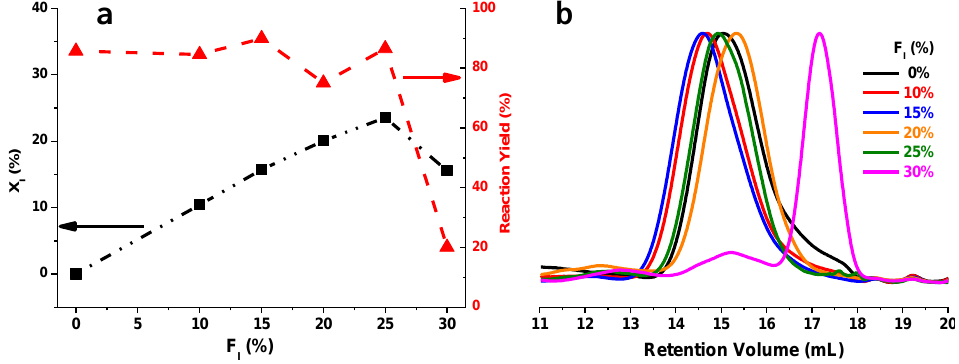
Figure 5. ( a ) The mole percentage of itaconate (X function of the feed ratio of dimethyl itaconate (F chromatography (GPC) elution curves in chloroform; PBSI was synthesized via the optimal conditions.